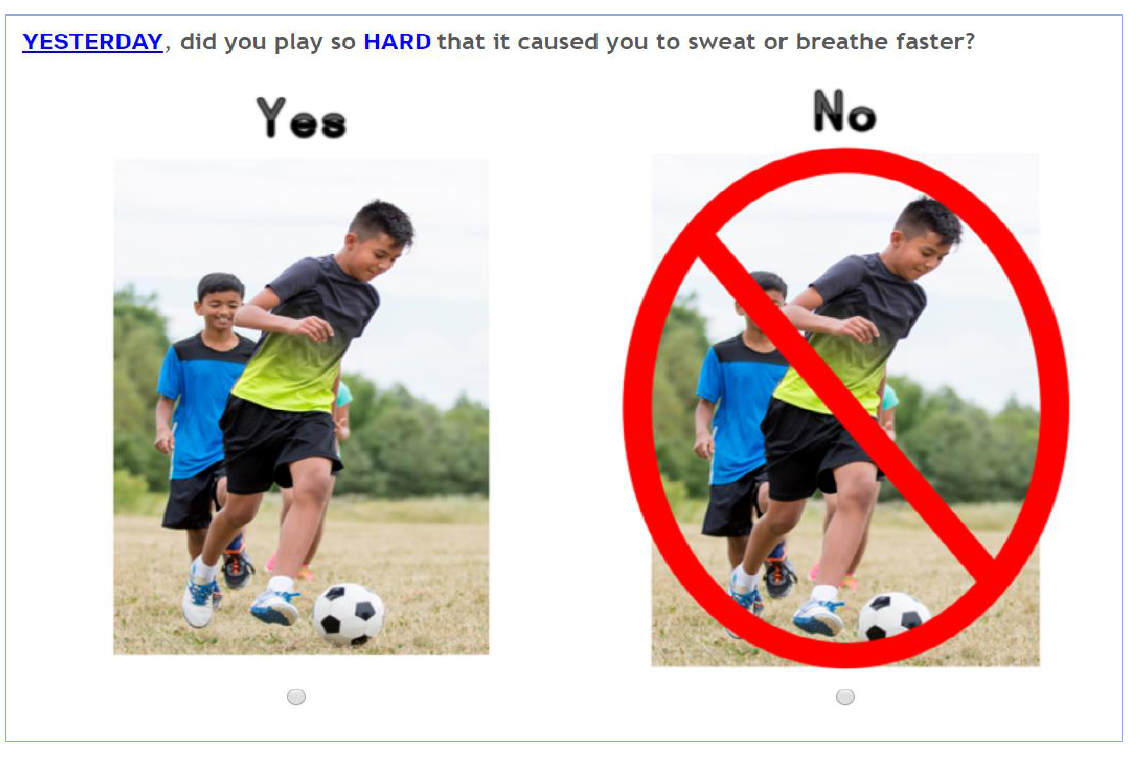
Figure 2. Sample CHAT Physical Activity